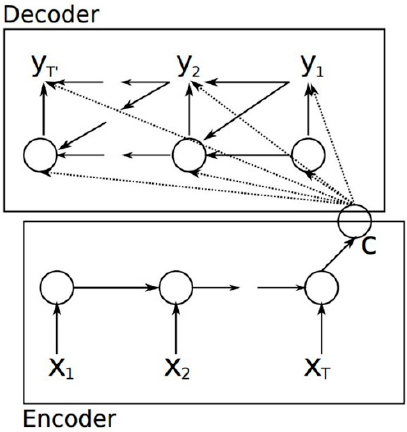
Figure 3. The sequence-to-sequence (seq2seq) model.